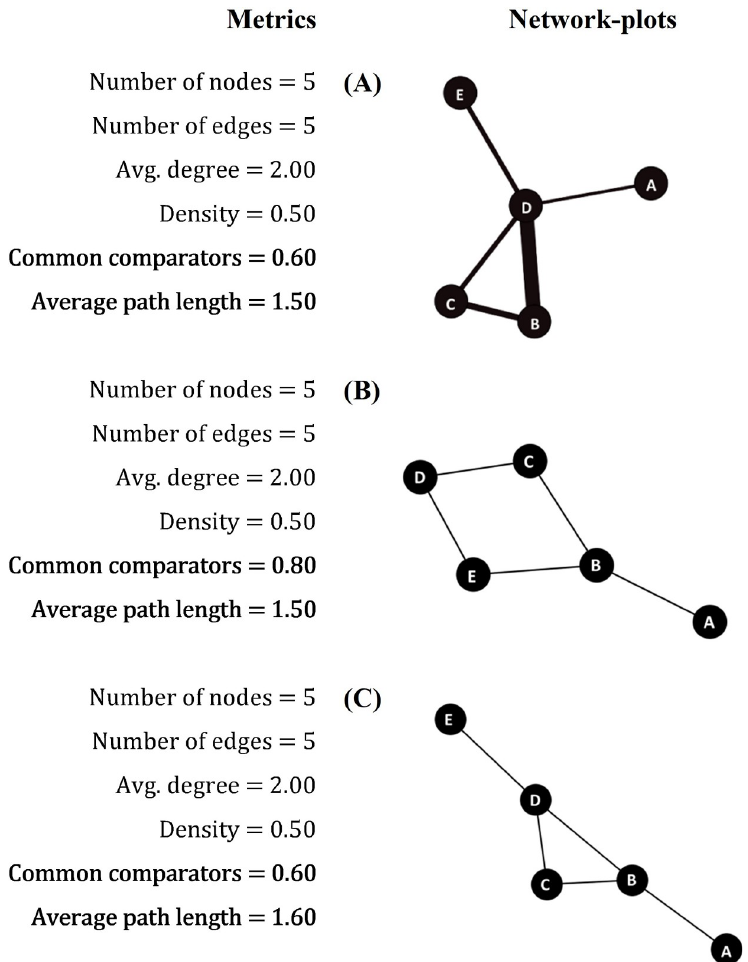
Fig 2. Sensitivity analyses for the assessment of geometry of NMAs with similar number of nodes and edges. Examples of three networks-plots from the 167 analyzed NMAs. Highlighted parameters showed different values among similar